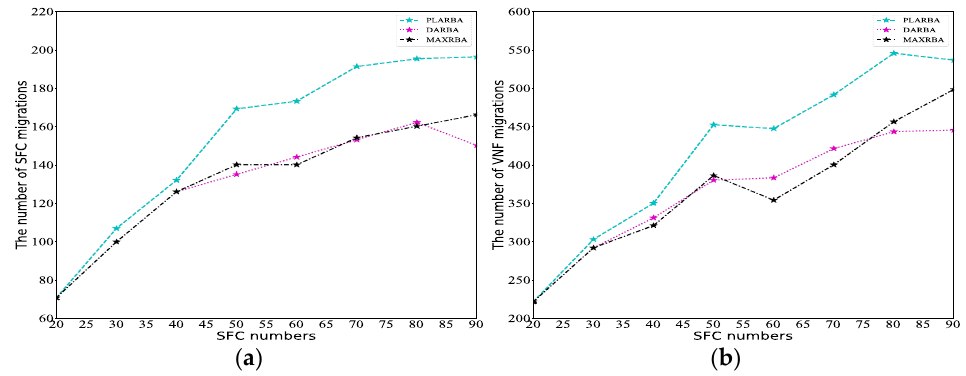
Figure 9. Migration times with respect to SFC numbers: ( a ) the number of SFC migrations; ( b ) the number of VNF migrations.